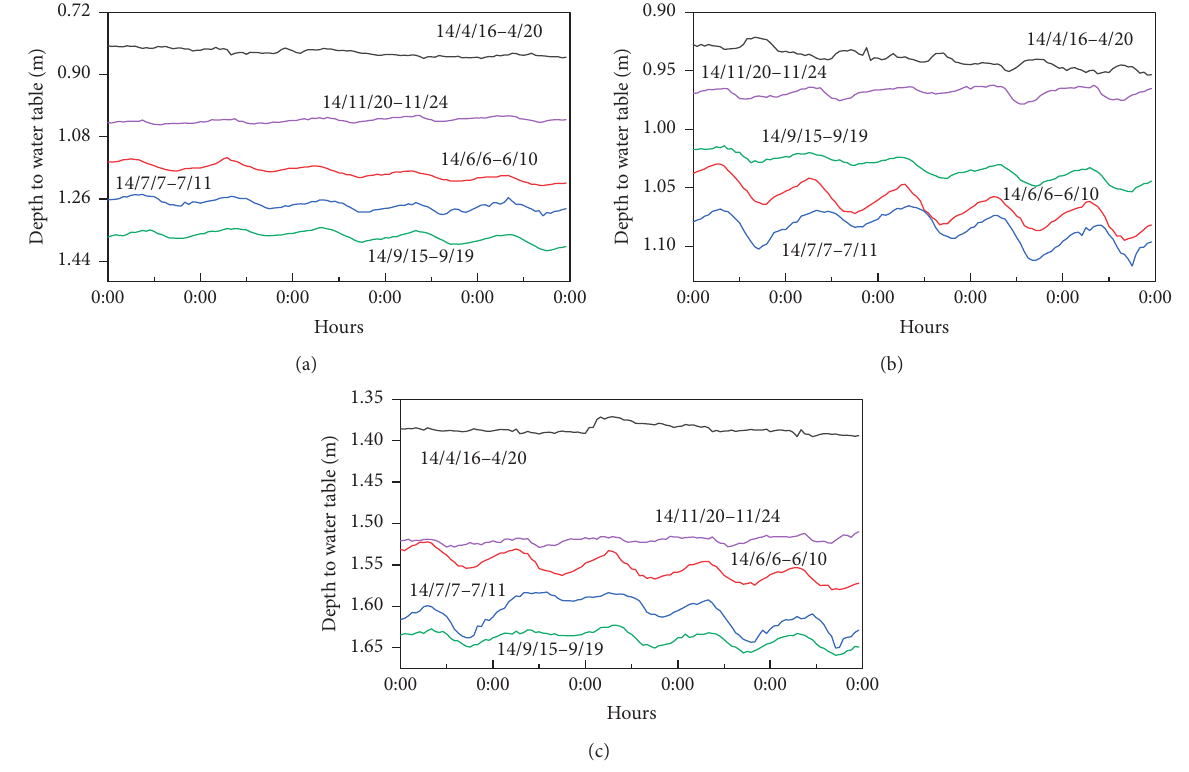
Figure 3: Seasonal variations in diurnal groundwater level fluctuations at observation site (a) G4, (b) G6, (c) G9.